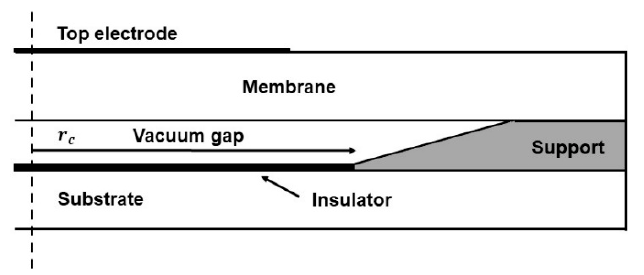
Figure 2. Schematic diagram of C2 (CMUT with an inverted frustum cone-like cavity).